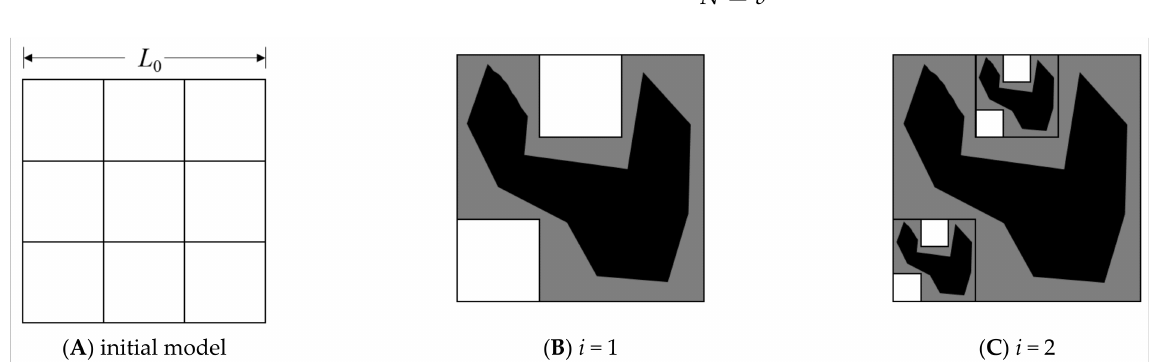
Figure 1. Basic constitution of fractal model. ( A ) The initial side length of the model in spatial dimension d E is L0, which is equally divided into N ; ( B ) the first iteration is divided into two subregions, namely, N z (light gray) and N (1 − z) (dark gray); ( C ) in the second iteration, the last iteration is repeated in the subregion N z ( d E = 2, b = 3, z = 2/9, D = ln2/ln3 = 0.631, N z =